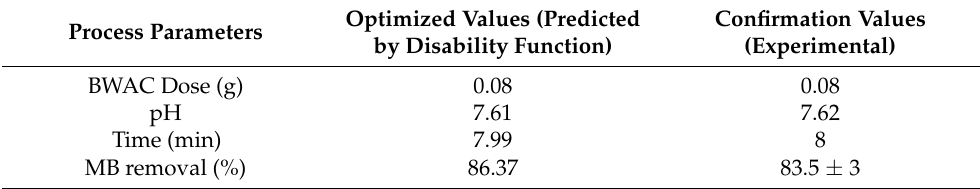
Figure 6. Input and output MB removal (%) responses in desirability ramp. Input variables (red point) and output response (blue point) MB removal (%) in desirability ramp. Table 5. Experimental and model-optimized values of parameters.